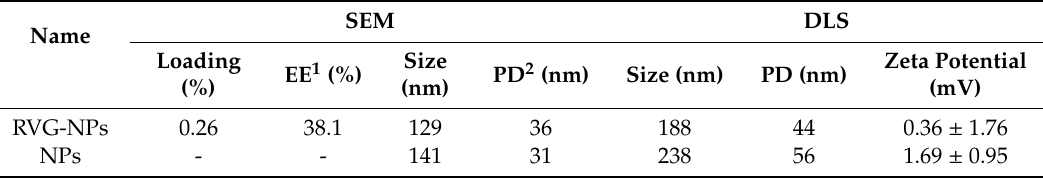
Table 1. Characteristics of Rabies Virus Glycoprotein modified, targeted nanoparticles (RVG-NPs) and control, non-targeted nanoparticles (Ctr-NPs) used in biodistribution studies [15].